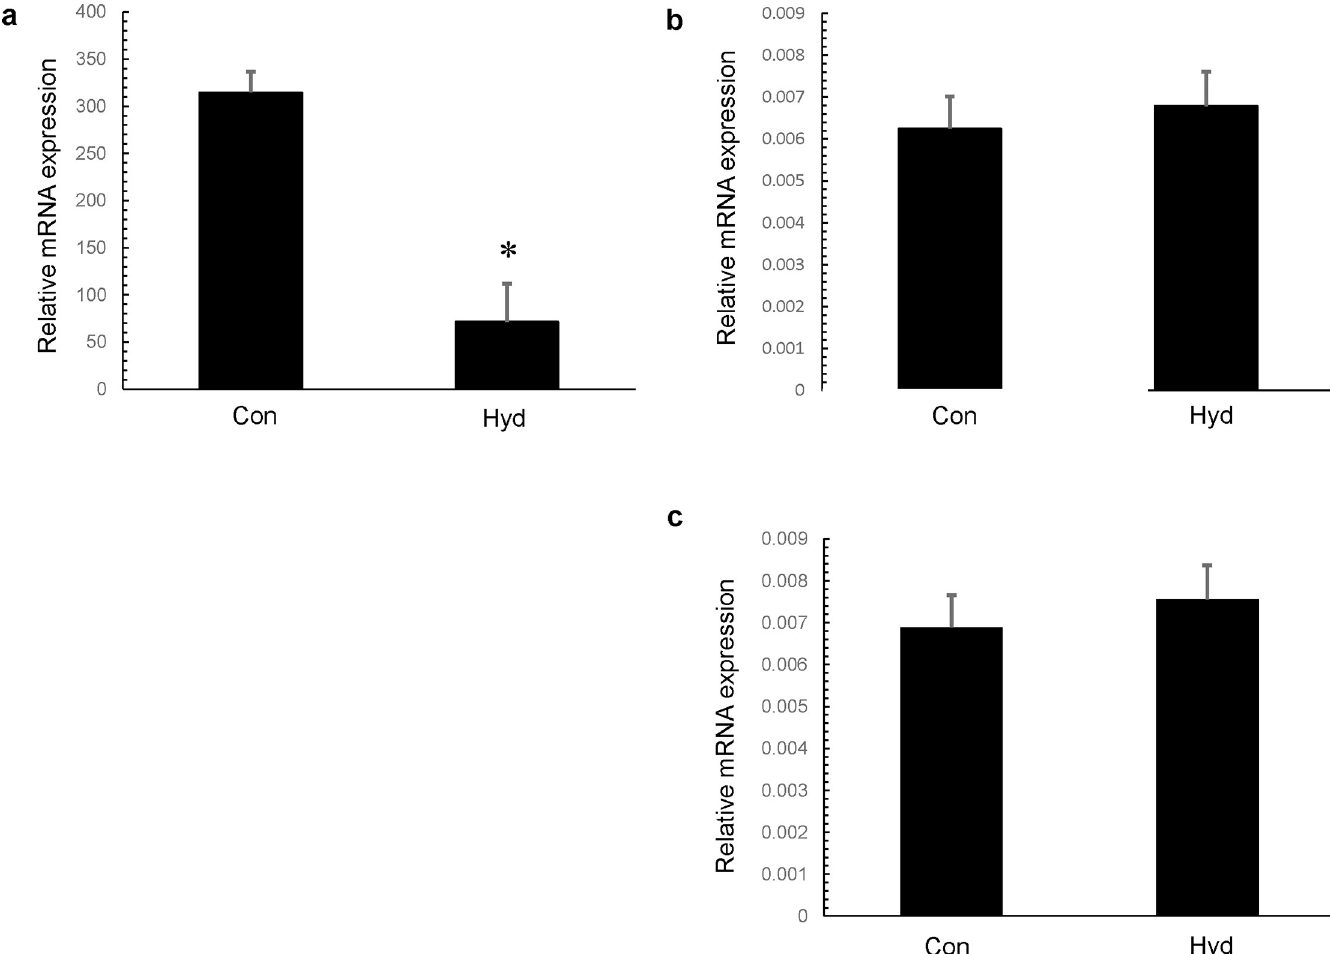
Fig 4. Effect of hydrogen gas inhalation on NADPH oxidase and NADPH oxidase subunits. Expression of NOX1 (a), p40phox (b) and p47phox (c) determined by real-time quantitative RT-PCR in femoral artery 7 days after cuff placement. Tissue samples were prepared from cuffed arteries 7 days after operation. Values are mean ± SEM (n = 5 for each group). Con; control group, Hyd; hydrogen group.